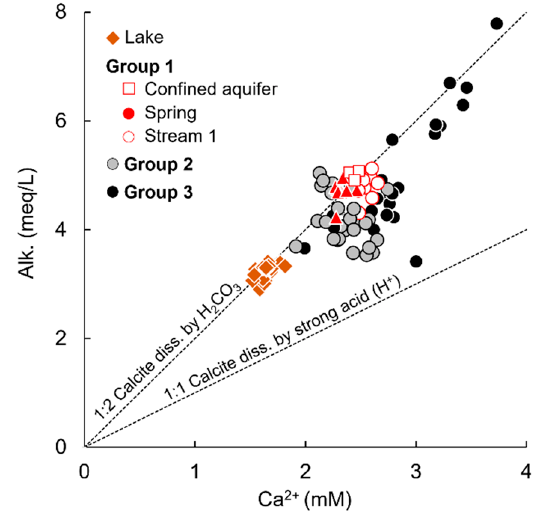
Figure 4. Concentrations of Ca 2 + and alkalinity of the streams, the spring, and the lake (Nørresø). The group number refers to the same stream grouping as presented for the isotope data (Figure 3). Lines indicate molar calcium:alkalinity ratios corresponding to calcite dissolution by carbonic acid (1:2) and strong acids (1:1).